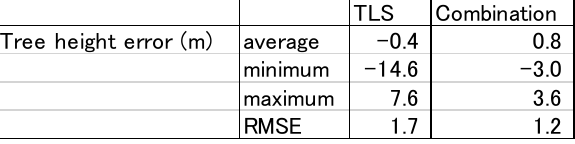
Table 6. Comparison of individual-level tree height measurements obtained by TLS and the combination method